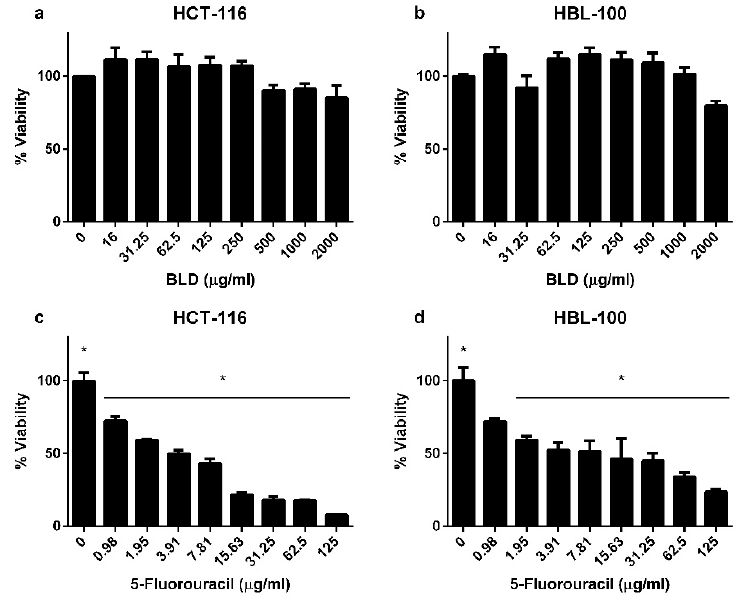
Figure 2. MTT viability of human colorectal cancer and epithelial non-tumoral mammary cell lines (HCT-116 and HBL-100, respectively) in a dose-response experimental design for 72 h. When BLD was used on both cell lines ( a , b ), the obtained results showed no-significant changes in cell viability among treatments and control groups. However, statistical differences were found in the treatment with 5-fluorouracil from 0.98 µ g/mL in HCT-116 ( c ) and 1.95 µ g mL in HBL-100 ( d ). ANOVA followed by Dunnett’s comparison test was used (asterisk indicates statistical significance, p ≤ 0.05).